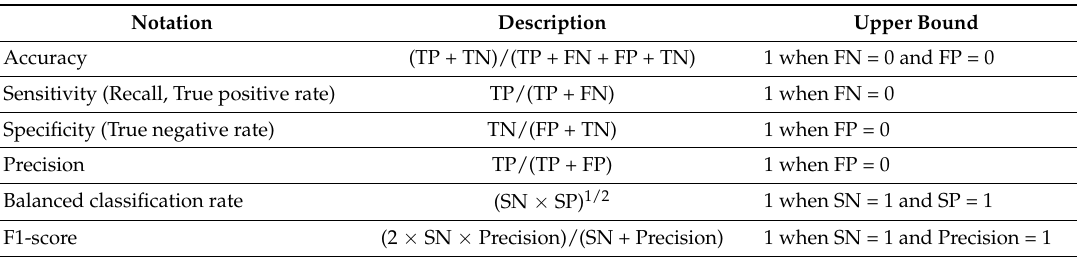
Table 2. Performance measures and their